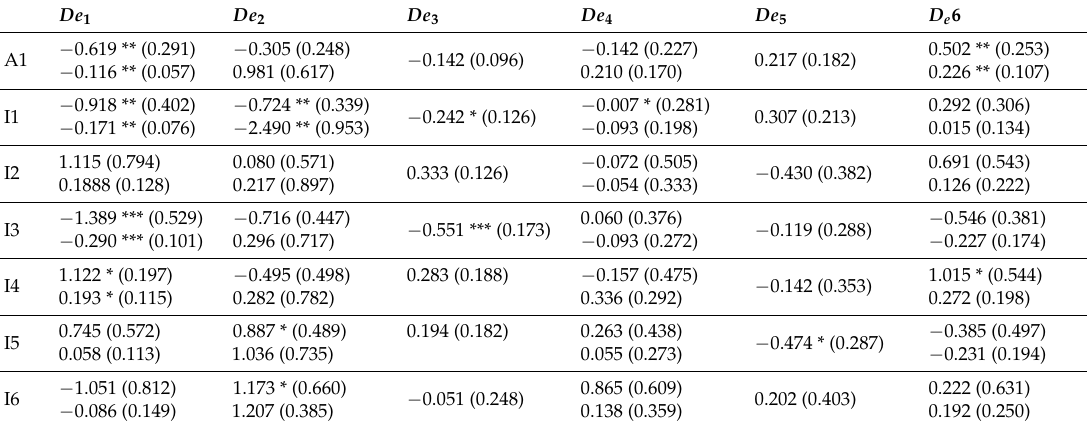
Log-Likelihood. The upper rows represent the results of the ordered logit model, whereas the bottom rows show the results of the tobit model. Table A2. Estimation results of the ordered logit and tobit models (part